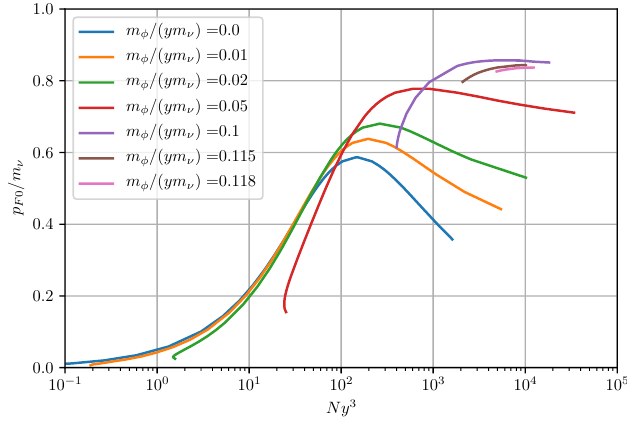
Figure 5 . Dependence of the Fermi momentum in the center of ν -cluster, p F 0 , on Ny 3 for different values of m ( m φ φ /ym ν